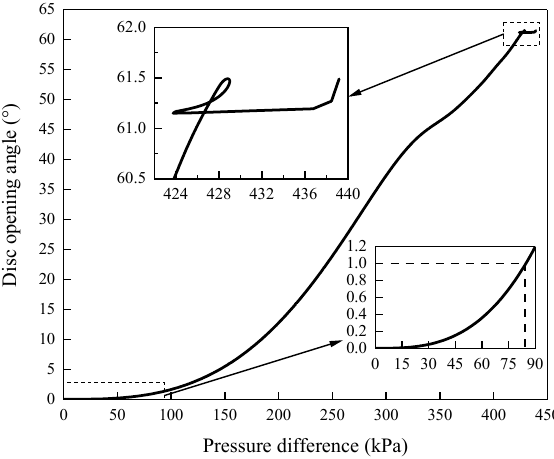
Figure 9. Relation between disc opening angle and pressure difference.